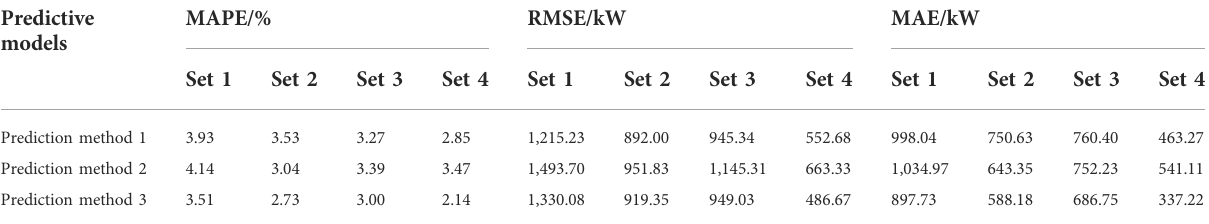
TABLE 6 Comparison of electrical load prediction results. Predictive